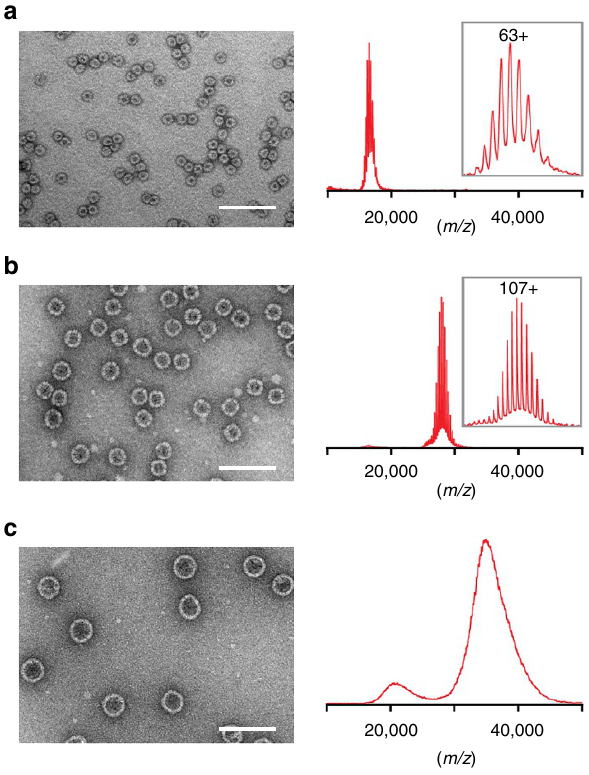
Figure 2 | Size expansion of the AaLS variants. ( a – c ) Negative-stain EM images and native mass spectra of AaLS-wt ( a ), AaLS-neg ( b ) and AaLS-13 ( c ). Scale bars, 100nm. The most abundant charge states are annotated for AaLS-wt and AaLS-neg. The spectra clearly indicate that AaLS-wt is a 60-mer and AaLS-neg is a 180-mer. For AaLS-13, the oligomeric state was estimated to be between a 240-mer and a 420-mer extrapolating from the charging behaviour of the other AaLS